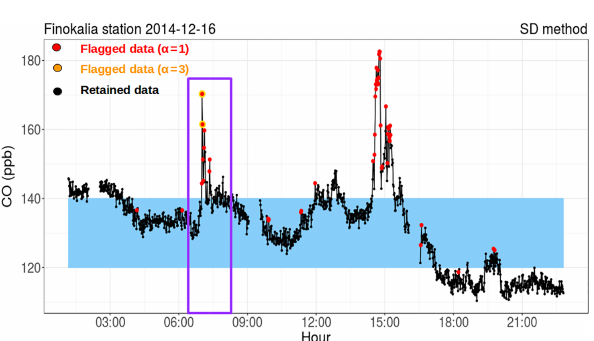
Figure 1. Comparison between two sets of α parameter for SD method. Red represents detected spikes for α = 1; orange data are the detected spikes for α = 3. The blue area shows the data between the first and the third quartile (q1 = 0.25, and q2 = 0.75).